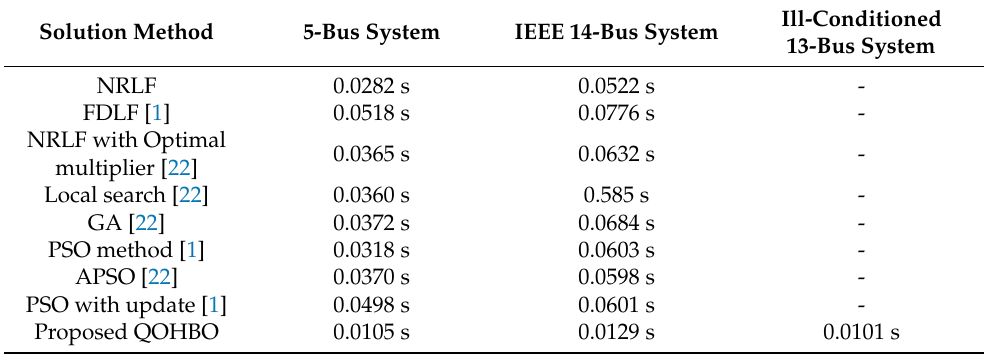
Table 8. Computational time taken per iteration in seconds for various